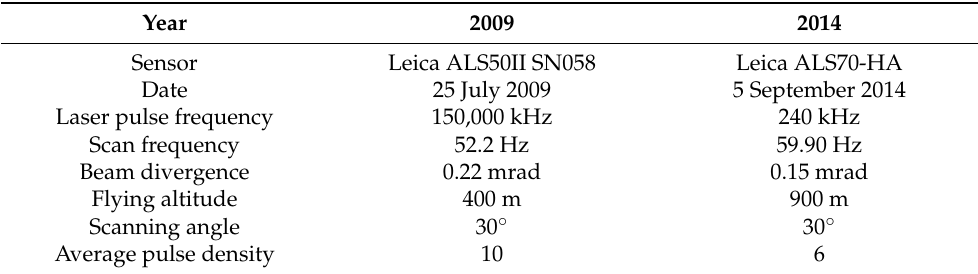
Table 2. The 2009 and 2014 ALS datasets and acquisition